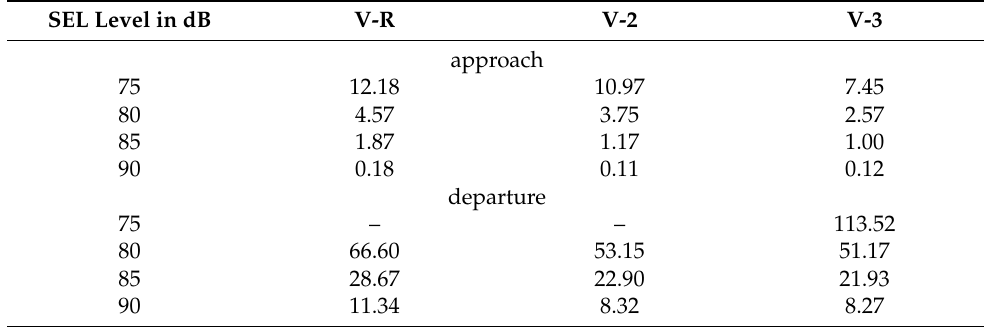
Figure 12. L A , max level 1000m sideline during departure ( ceo ) with and without applied shielding. Table 7. Sizes of iso-contour areas in km 2 , ceo